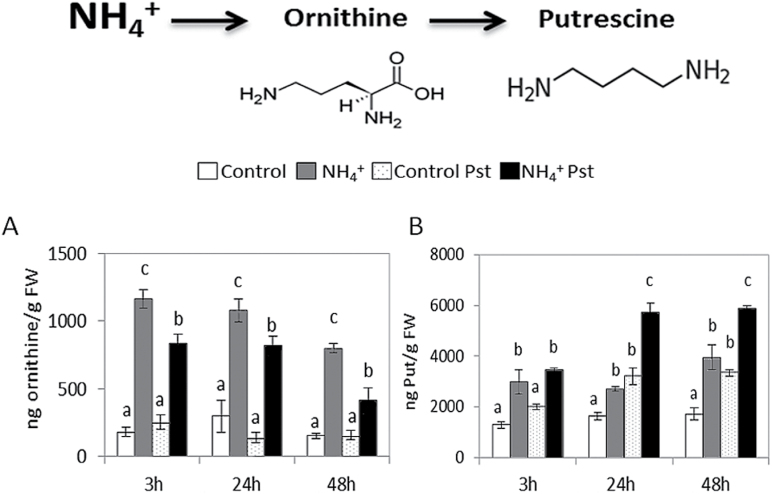
PA content in control and N-NH4
+ tomato plants following Pst infection. Four-week-old tomato plants were grown under control conditions or with 5mM NH4
+, and inoculated by dipping them in a bacterial suspension of Pst at 5×105 cfu ml−1. Leaves were collected at various time points, and ornithine (A) and Put (B) levels were determined in freeze-dried material by HPLC–MS. Data show the average of three independent experiments of a pool of 10 plants per experiment ±SE. Letters indicate statistically significant differences (P<0.05; least-significant difference test).